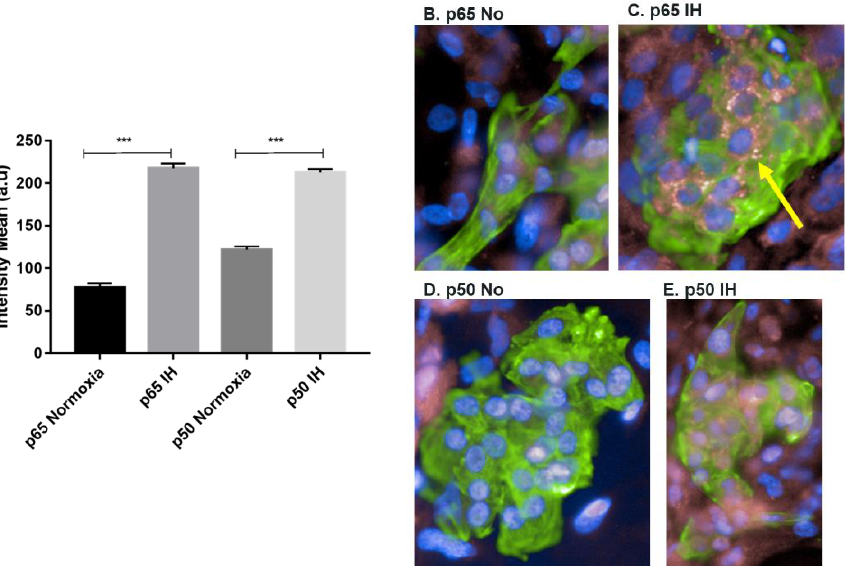
Figure 3. Increase in nuclear NF- κ B sub-units p65 and p50 expression in hESC-CMs following